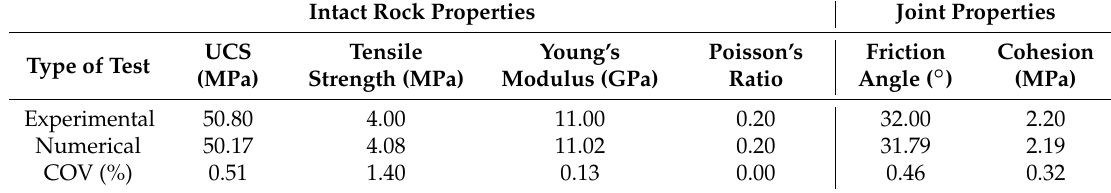
Table 2. Mechanical properties of Hawkesbury sandstone [8] and calibrated BPM material.